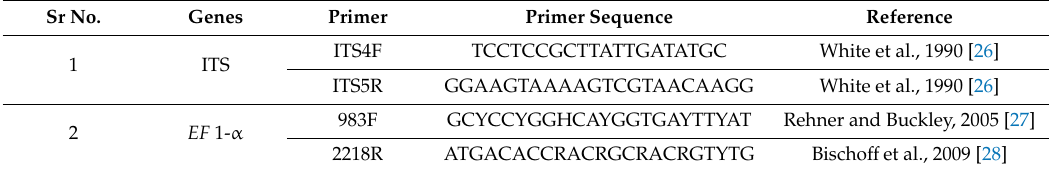
Table 1. Primers used in this study. ITS: internal transcribed spacer, EF 1- α : elongation factor 1 alpha. Sr No. Genes Primer Primer Sequence Reference ITS4F TCCTCCGCTTATTGATATGC White et al., 1990 [26] 1 ITS ITS5R GGAAGTAAAAGTCGTAACAAGG White et al., 1990 [26] 983F GCYCCYGGHCAYGGTGAYTTYAT 2 EF 1- α 2218R